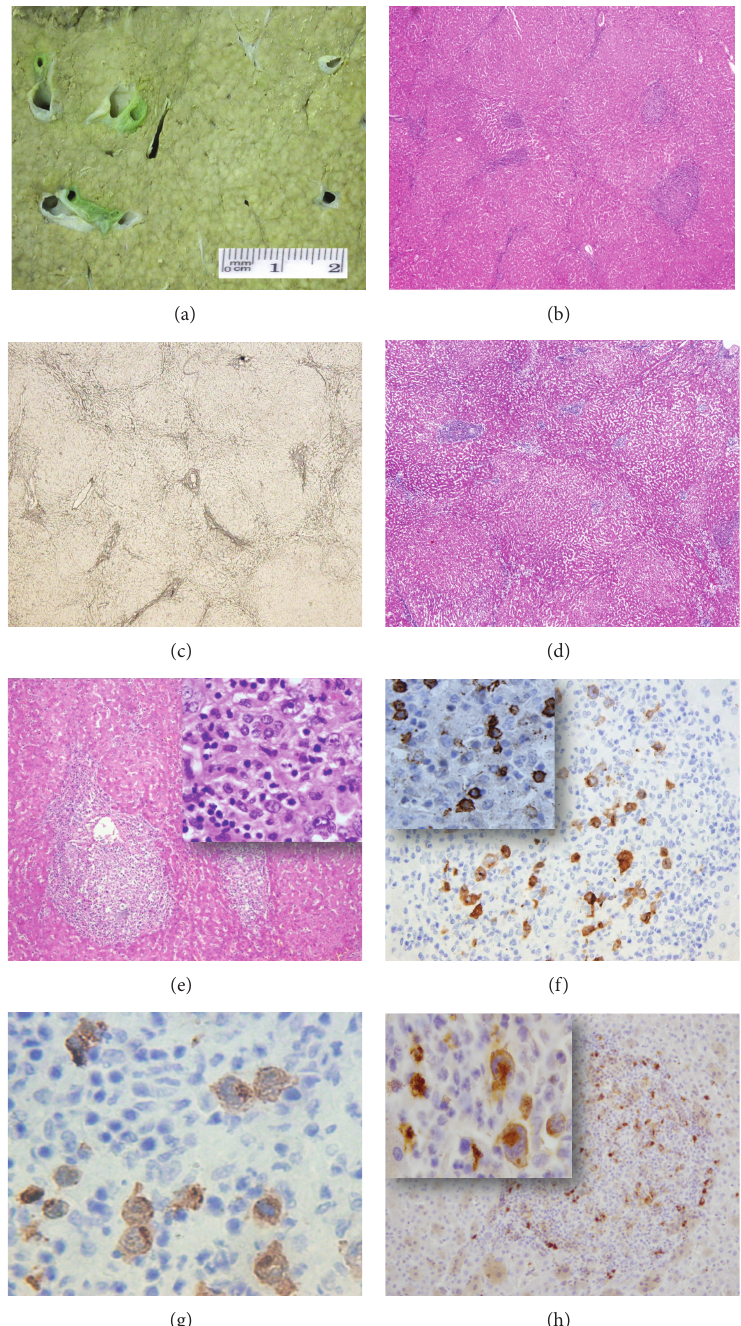
Figure 1: (a) Cut surface of the liver with a micronodular appearance. (b) H&E 4X, Highlighting nodularity. (c) Reticulin stain 4X, again highlighting nodularity. (d) Trichrome satin 4X, showing absent fibrosis. (e) H&E 4X, portal space with chronic inflammatory infiltrate, inset 40X, Reed-Stenberg cells on a lymphoid background. Immunohistochemical studies: (f) LMP 40X, inset CD 20 100X. (g) CD 30 100X, presenting Positive Reed Stenberg cells and (h) CD 15 40X and Inset CD 15 100X, presenting Positive Reed Stenberg